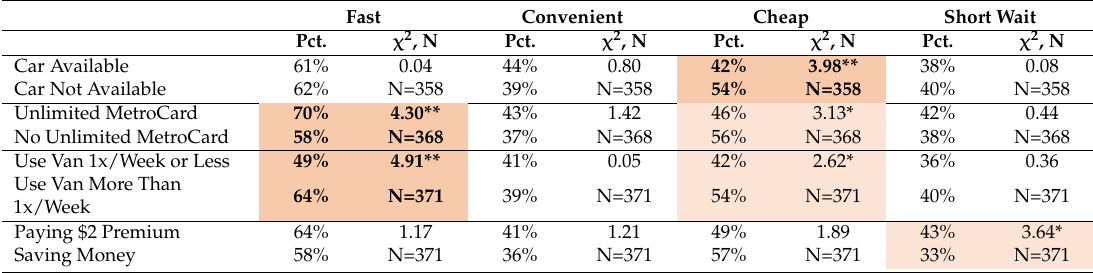
Table 5. Associations between respondent reasons for riding vans and transport choices. Fast Convenient Cheap Short Wait Pct. χ 2 , N Pct. χ 2 ,